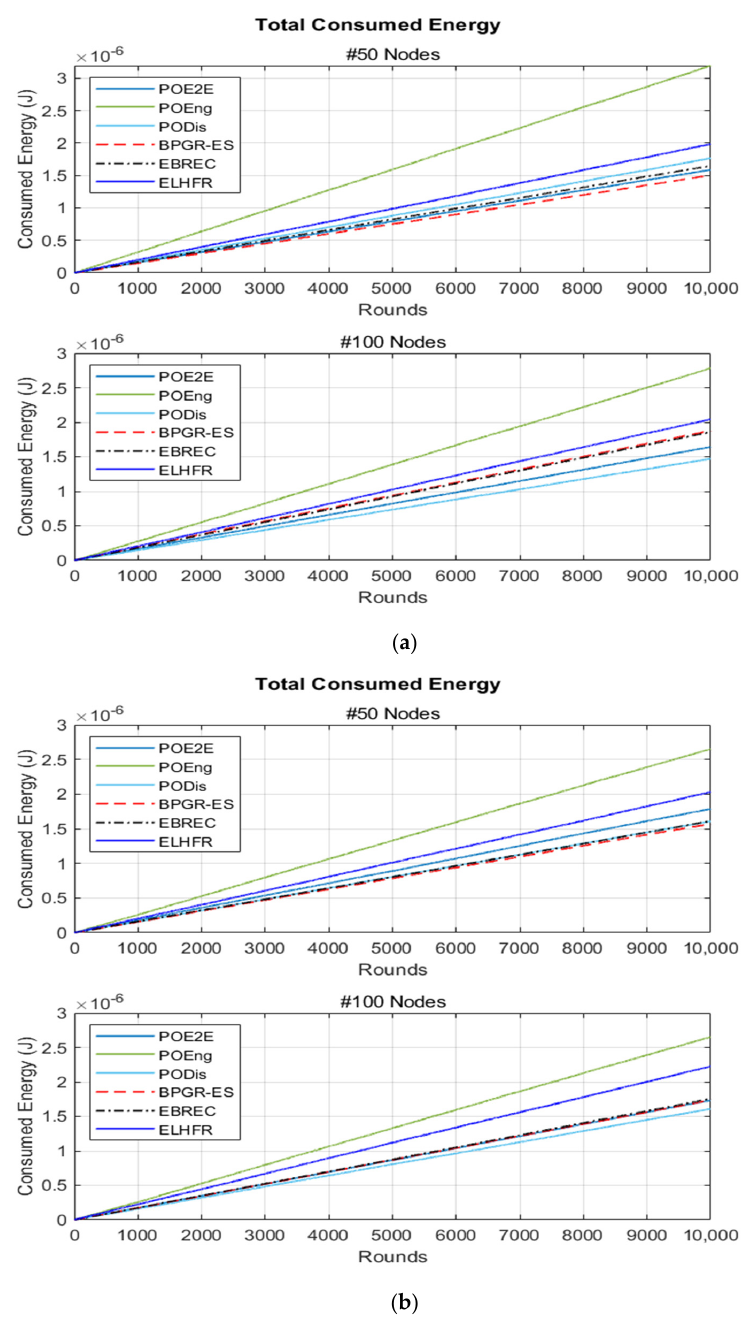
Figure 5. Total Consumed Energy for different topologies: ( a ) energy consumption results of the 100 × 100 𝑚 (cid:2870) network area of 50 and 100 sensor nodes; ( b ) energy consumption results of the 200 × 200 𝑚 (cid:2870) network area of 50 and 100 sensor nodes. Notably, upon increasing sensor nodes, total energy consumption of PODis is evi- dently reduced due to the larger number of sensor nodes, with the shortest path being chosen in the quickest way, thereby significantly reducing energy consumption.